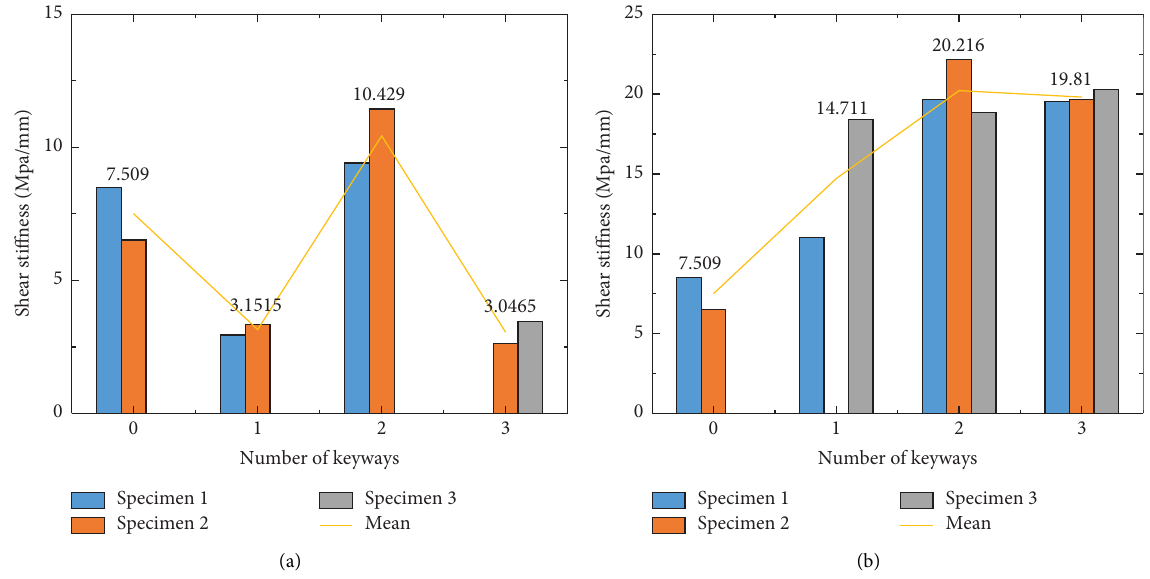
Figure 12: Interfacial bond stifness with diferent interfacial agents. (a) Te interface slip stage. (b) Te keyway strengthening stage.